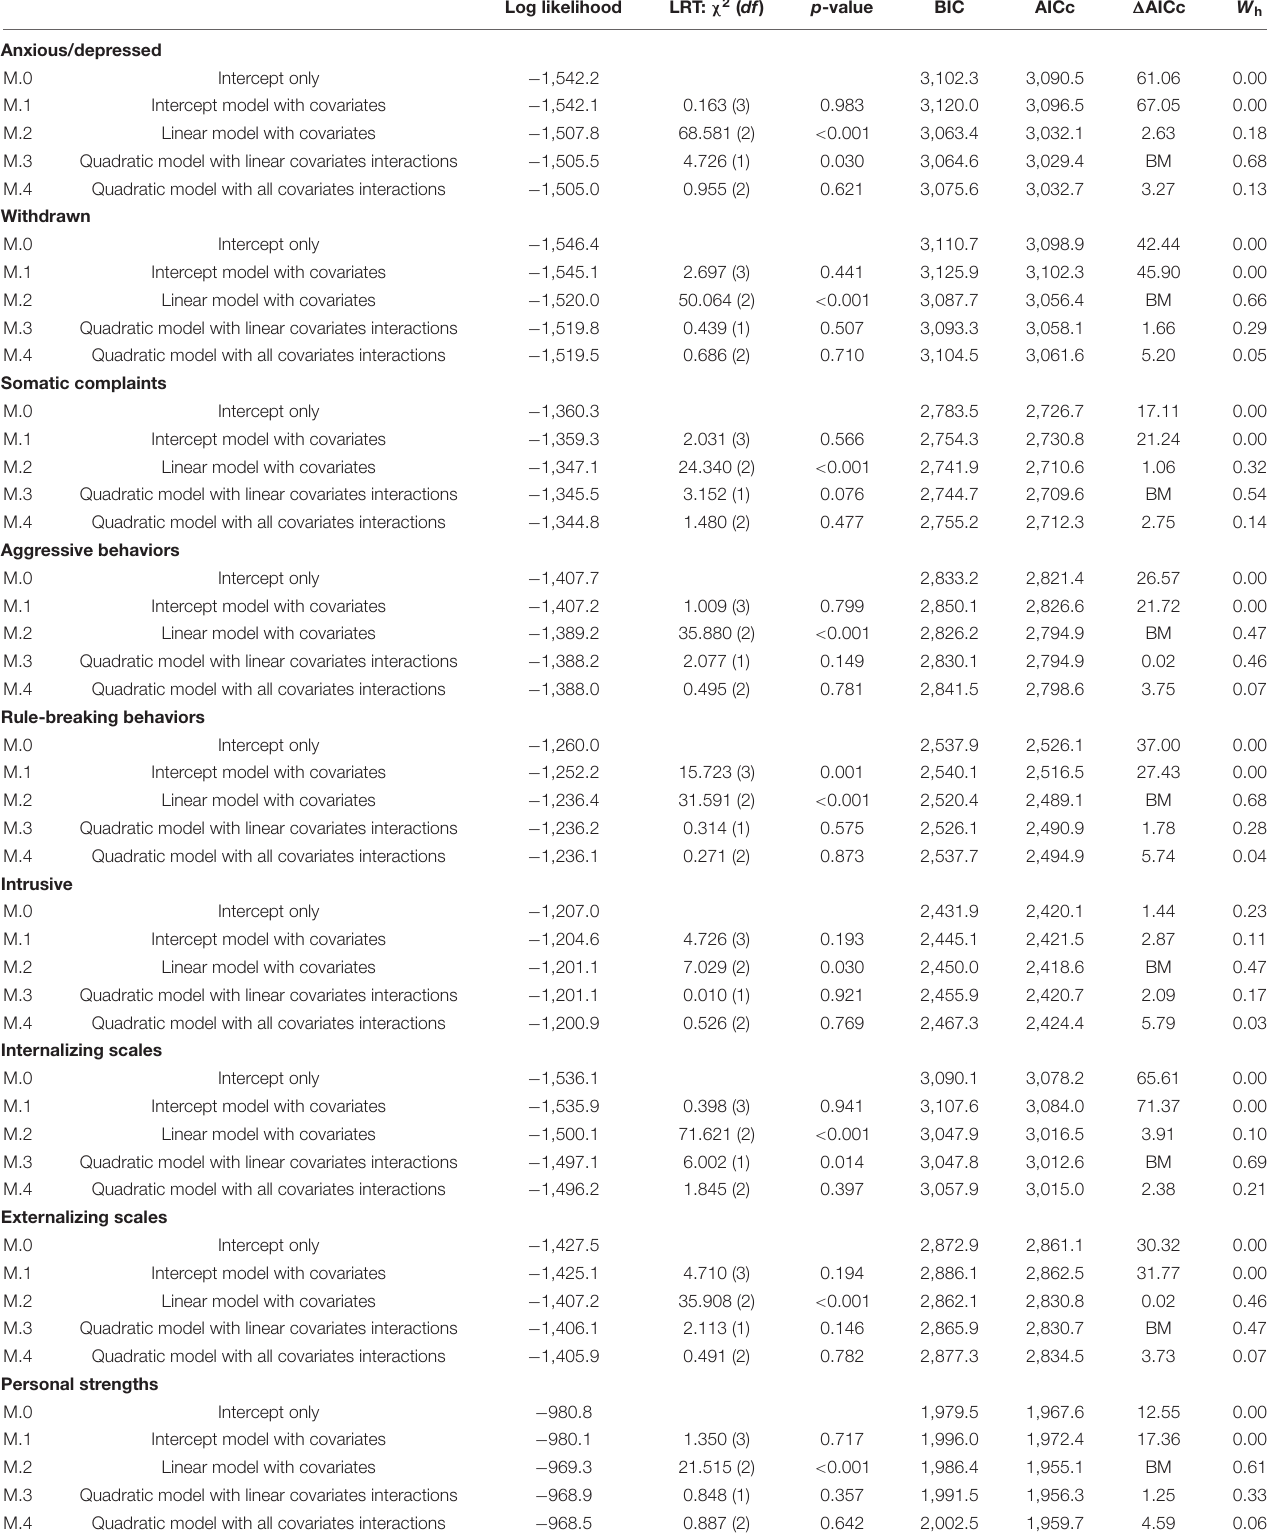
TABLE 3 | Model comparisons for each ASR